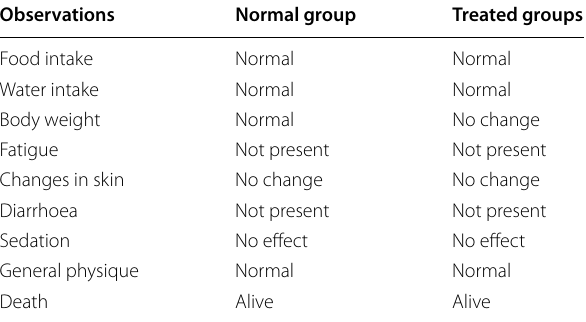
Table 2 General appearance and behavioral observations of control and treated